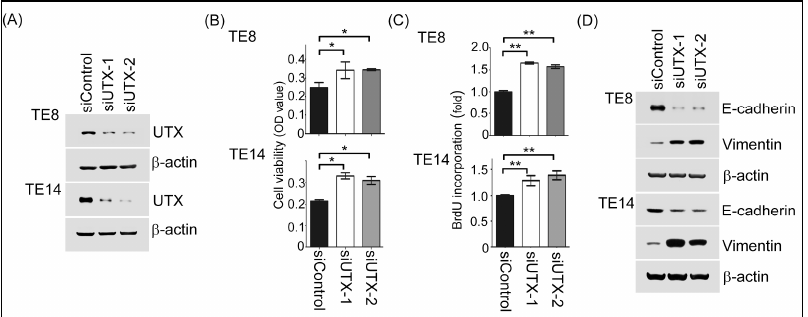
Figure 3. UTX expression regulated cell growth and epithelial-mesenchymal transition (EMT) expression in TE8 and TE14 cells. ( A ) The protein expression level of UTX was demonstrated in TE8 cells transfected with siControl and si UTX using Western blotting analysis. ( B , C ) The cell growth abilities of siControl and si UTX in TE8 and TE14 cells were measured by MTT (3-(4,5-dimethylthiazol-2-yl)-2,5-diphenyltetrazolium bromide) and BrdU assays. ( D ) The E-cadherin, and Vimentin protein expression levels were investigated with Western blotting analysis in TE8 and TE14 cells transfected with siControl and si UTX . * , p < 0.05; ** , p < 0.01.